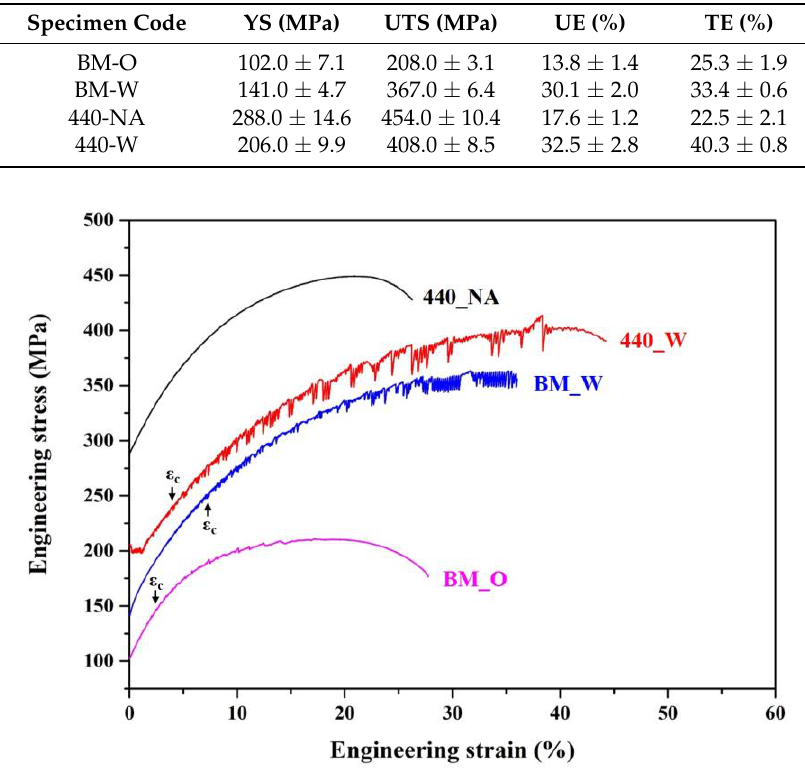
Figure 3. Stress – strain flow curves of 7075 aluminum alloy after FSP and various heat treatments.